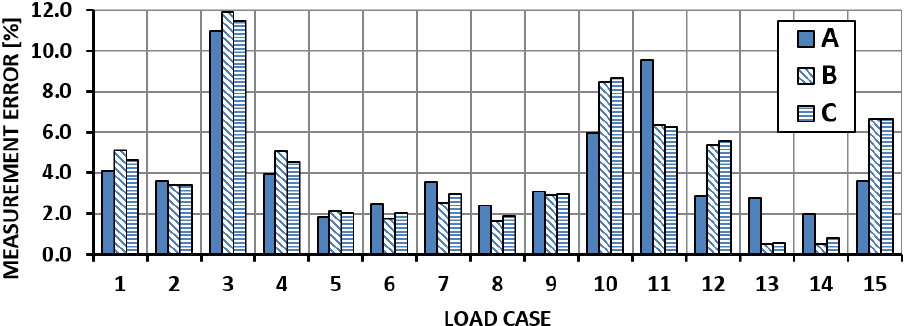
Figure 8. Shear force measurement error—Section II.